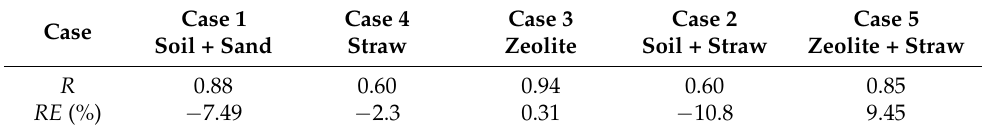
Table 5. Statistical parameters for TP concentration simulation.